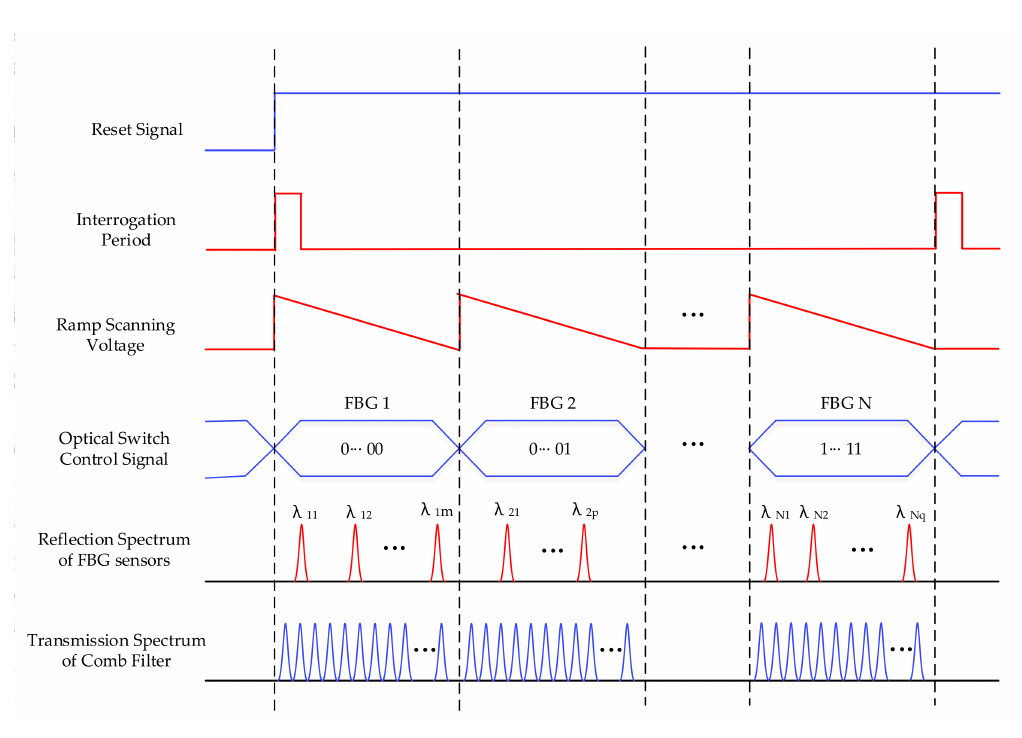
Figure 3. Typical sequence diagram of the